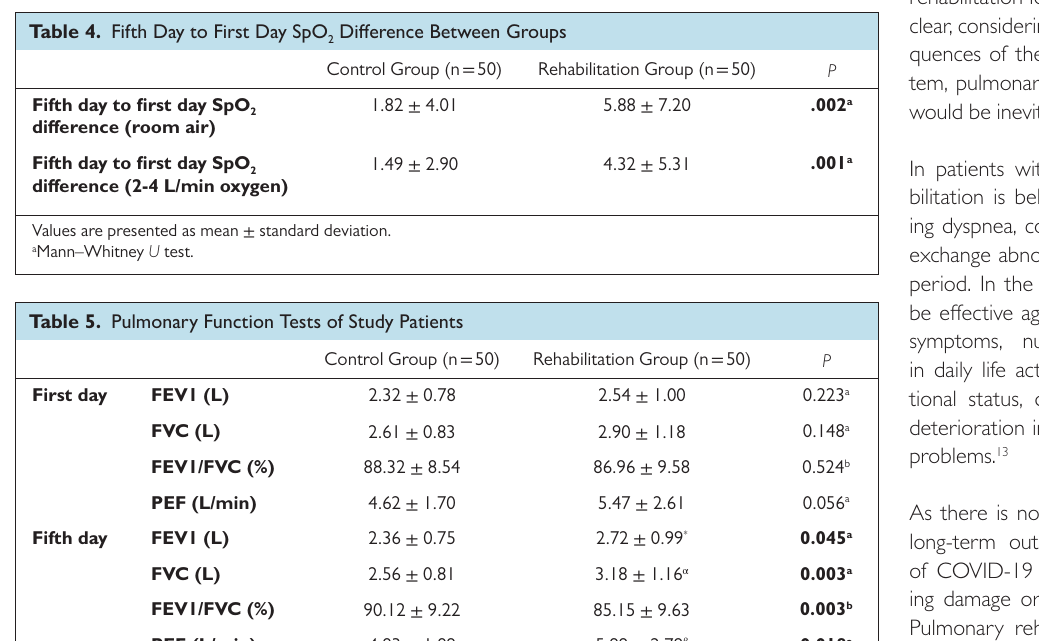
Table 4. Fifth Day to First Day SpO